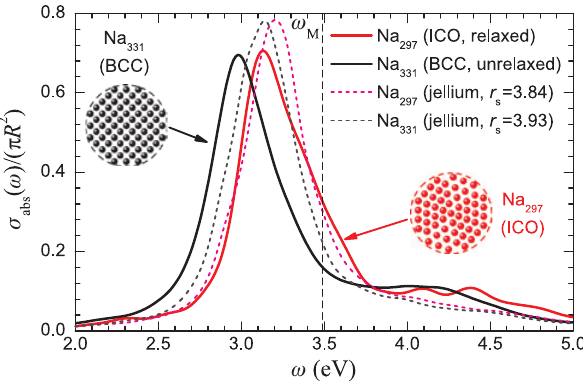
Figure 4: Normalized TDDFT absorption cross section for Na iso- lated cluster. Solid black line: BCC Na black dotted line: jellium Na classical Mie plasmon frequency for the mean density of bulk Na is indicated by a vertical line. Figure adapted from Ref.